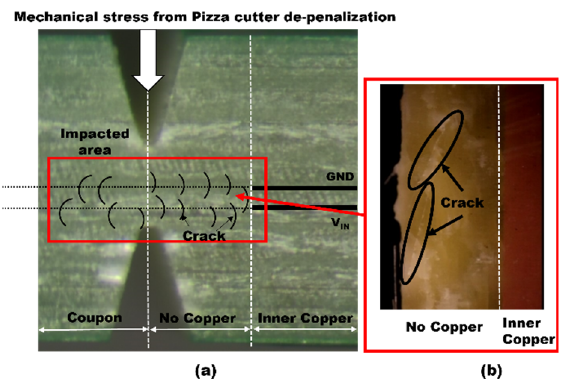
Figure 3. Cross-section of the PCB: ( a ) potential crack location; ( b ) after pizza cutter (V-cut) de-panel process.